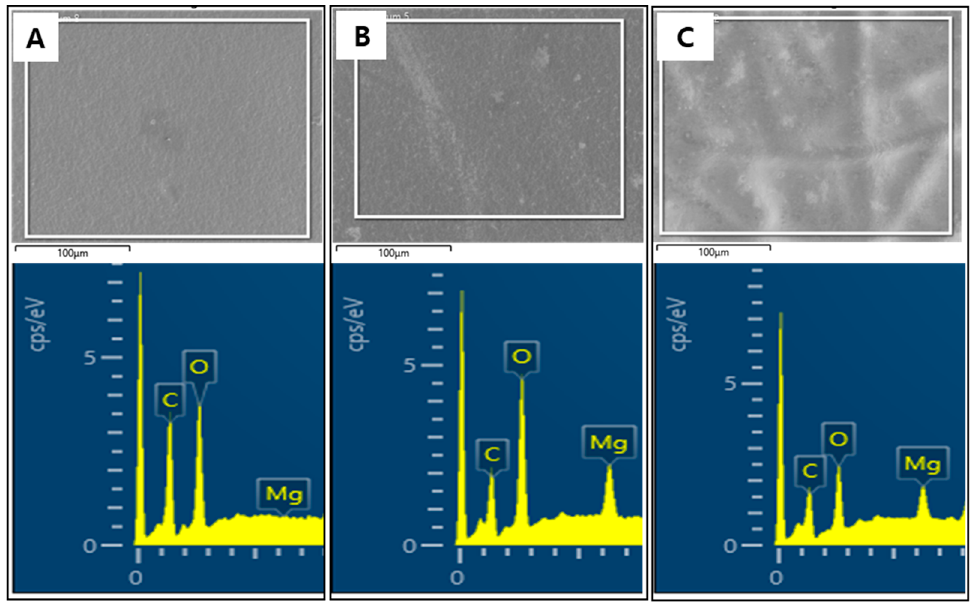
Figure 3. EDX results of ( A ) GOM, ( B ) Mg-GOM, and ( C ) Mg-rGOM(TH).